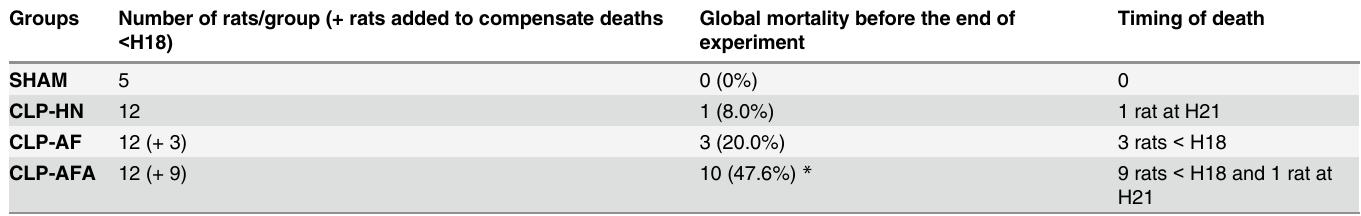
Table 2. Because of an early important mortality after CLP surgery, but before hemodynamic measurement were started ( < 18 th hour), the number of rat has been increased in groups were rats died (cid:3) 18 th hour (H18) after surgery. Groups Number of rats/group (+ rats added to compensate deaths < H18)